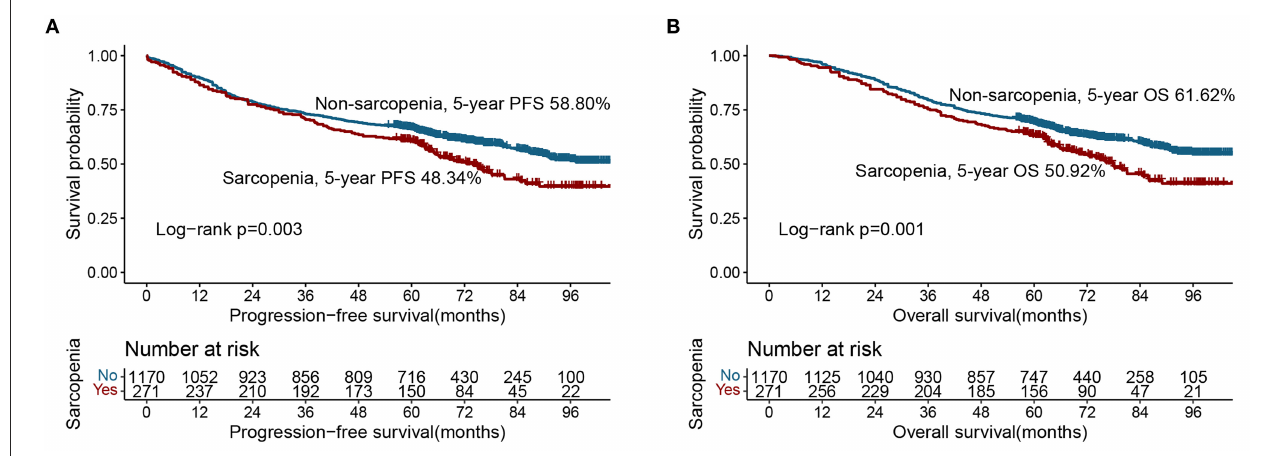
FIGURE1 Kaplan-Meier curve of sarcopenia in CRC patients. (A) Progression-free survival; (B) Overall survival.